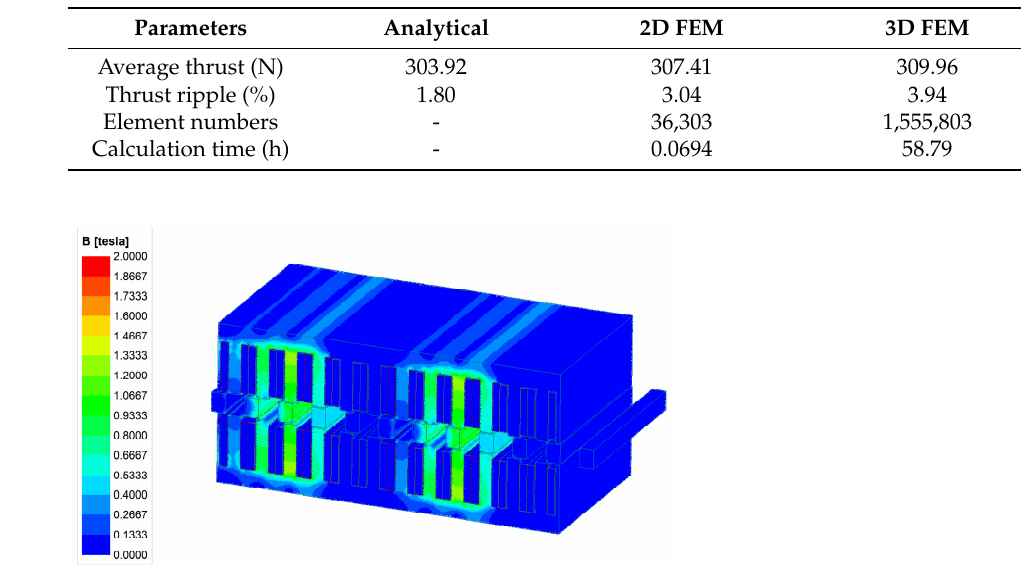
Figure 17. The average thrust and efficiency under different AC currents and DC currents of DCB ‐ VRLM with non ‐ uniform air gap. Table 6. Comparison of different calculation methods.